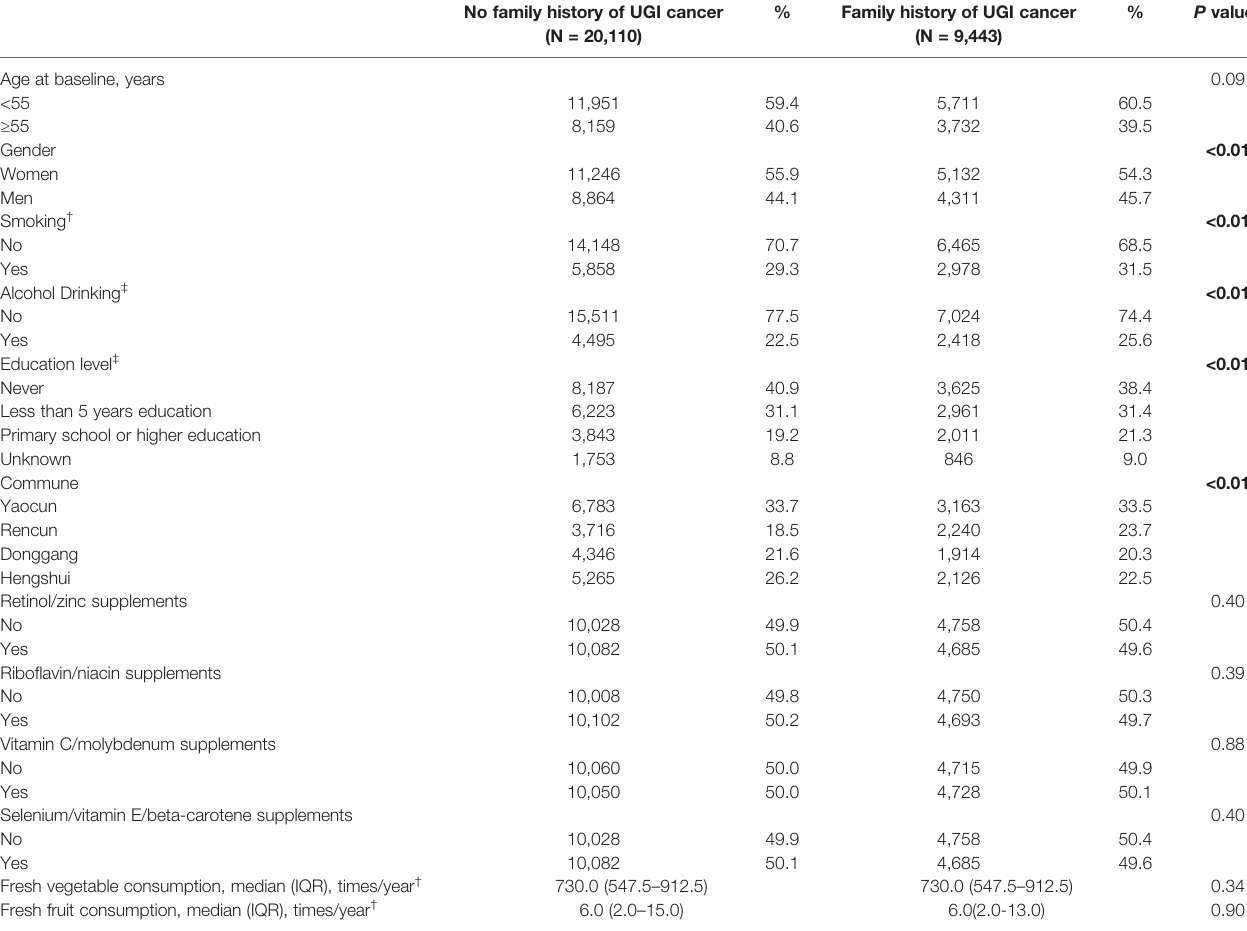
TABLE 1 | Baseline demographic characteristics by family history of UGI cancer in the Linxian General Population NIT Cohort.